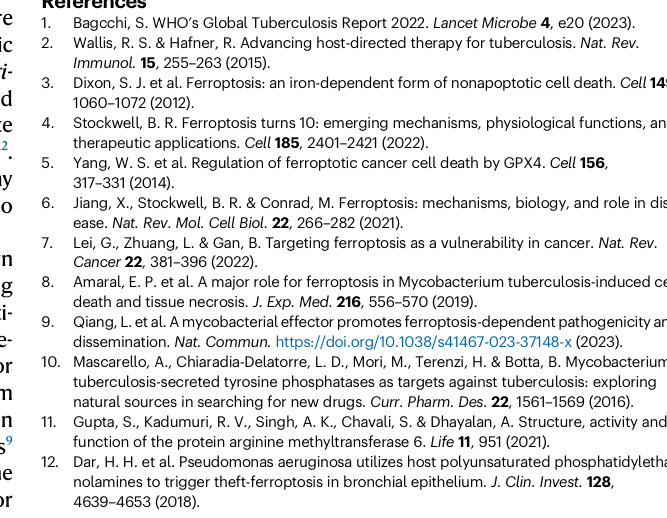
Fig. 1 | Mtb induces host cell ferroptosis to promote its pathogenicity and dissemination through its effector protein PtpA. In host cells, the system x c − importscystine, which isthenreduced to cysteineforGSH synthesis.GPX4utilizes GSH as a co-factor to neutralize lipid peroxides for ferroptosis suppression. Mtb- secreted effectorproteinPtpAentersthe hostcellnucleusbyinteractingwithRan- GTP, and promotes PRMT6-mediated H3R2me2a on the GPX4 promoter. This